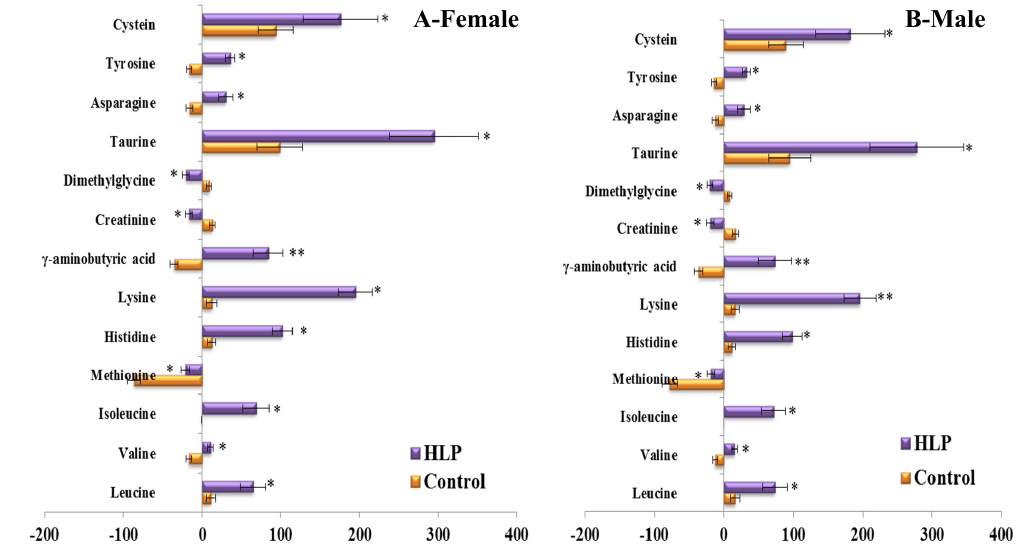
Figure 5. Percent changes of metabolites from fasting to 2-h samples during an OGTT between female ( A ) and male ( B ) in the control (Orange) and HLP groups (Purple). Percent changes for the metabolites (X) detected by UPLC-TQ-MS were calculated as follows: X Percent change = (X Concentration at different time (120) ´ X Concentration at baseline )/(X Concentration at baseline ). * p < 0.05, ** p < 0.01, compared with the control group using student’s t